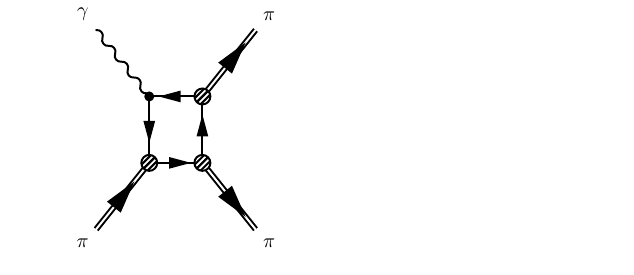
Figure 1. Feynman diagram which describes transition form factor γ ∗ π − → π 0 π − . All vertices are